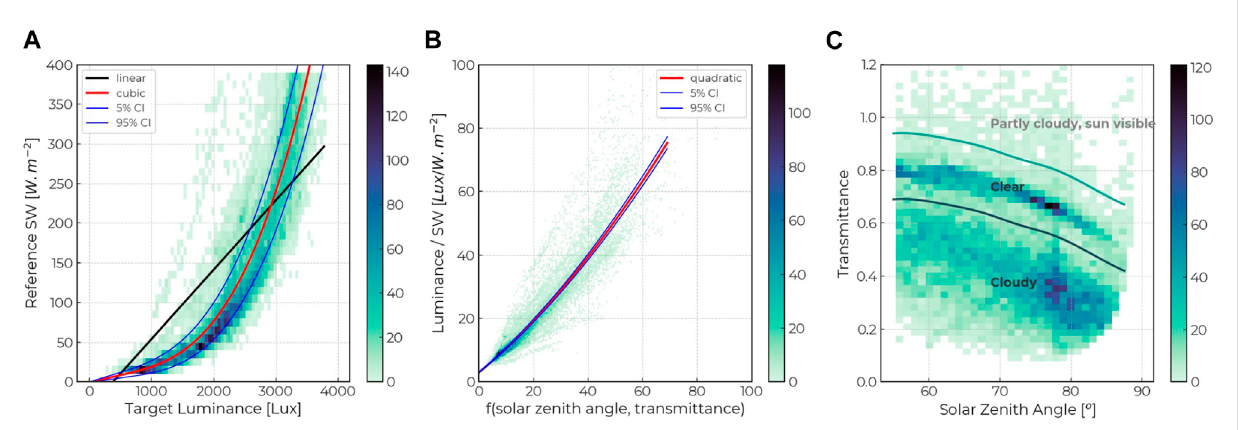
FIGURE 9 PerformanceforthetargetlightsensorVEML7700againstthereferenceshortwaveradiationsensorKippandZonenCMP22. (A) Histogramshowing the direct relationship between white luminance measured by VEML7700 and outgoing shortwave radiation from CMP22. (B) Histogram showing the fi ttedfunction of thesolarzenith angle and transmittanceto luminance against the ratio ofluminanceover outgoingshortwaves. (C) Histogram showing the solar zenith angle vs. transmittance measure, highlighting the sky conditions (cloudy, clear sky, thin cloud with